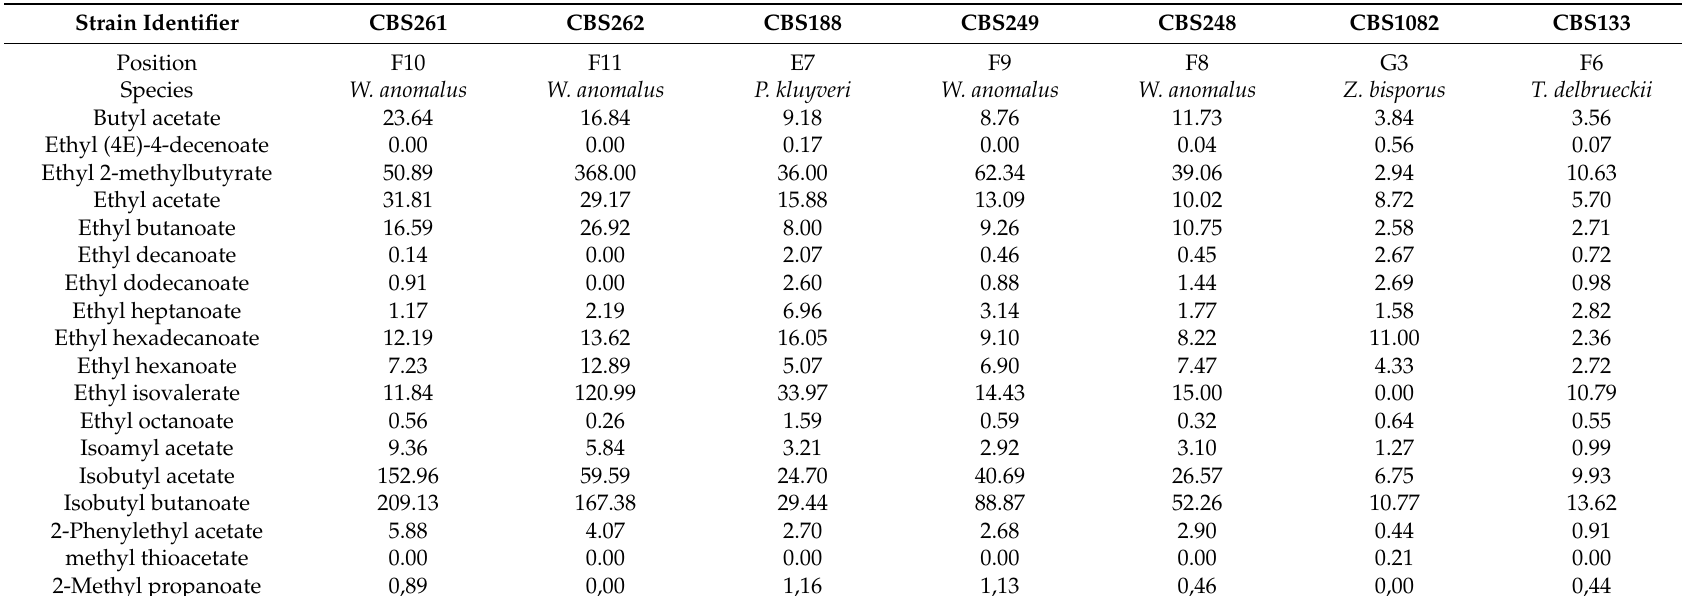
Table 4. Strains with higher aroma ester production than the Weihenstephan lager yeast